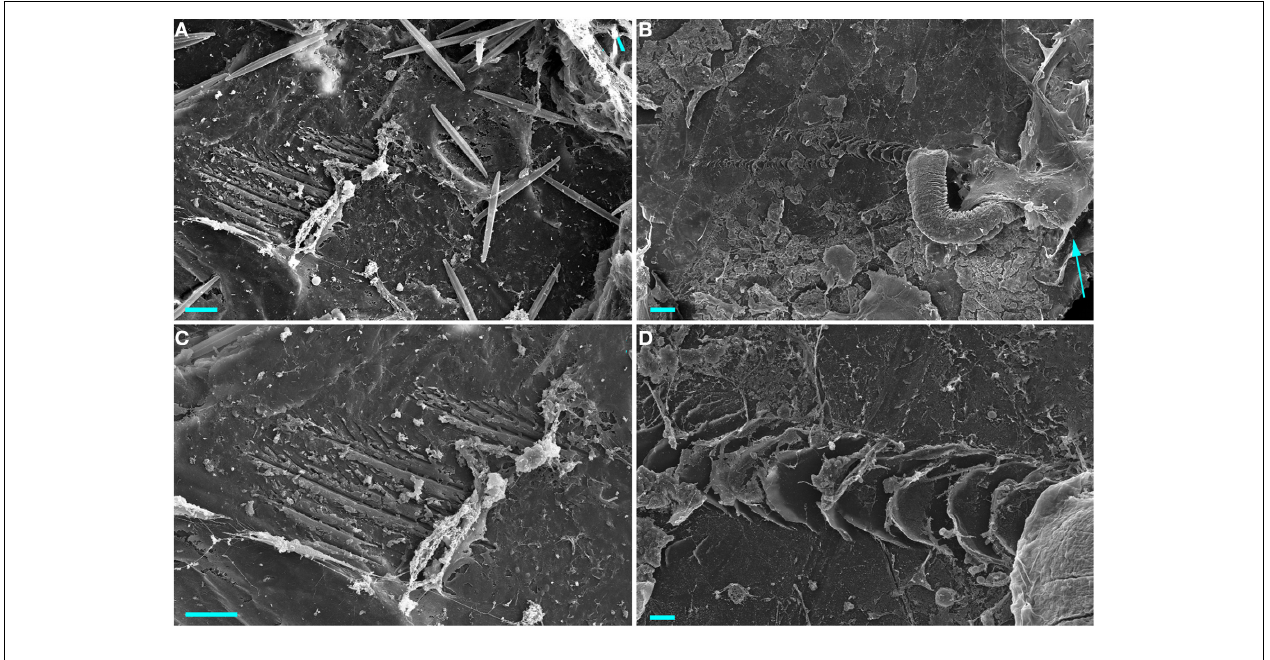
FIGURE 1 | Scrapes putatively identified as feeding marks. (A) Linear scrape marks on a 2.3mm long plastic debris with a high load of diatoms. (B) Rounded scrape marks on a 6mm long plastic with a unidentified